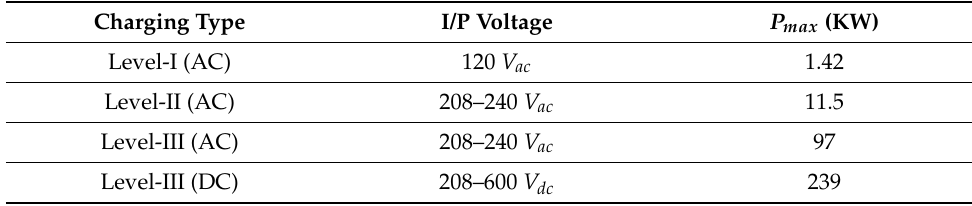
Table 1. Various Charger Types for PHEVs.